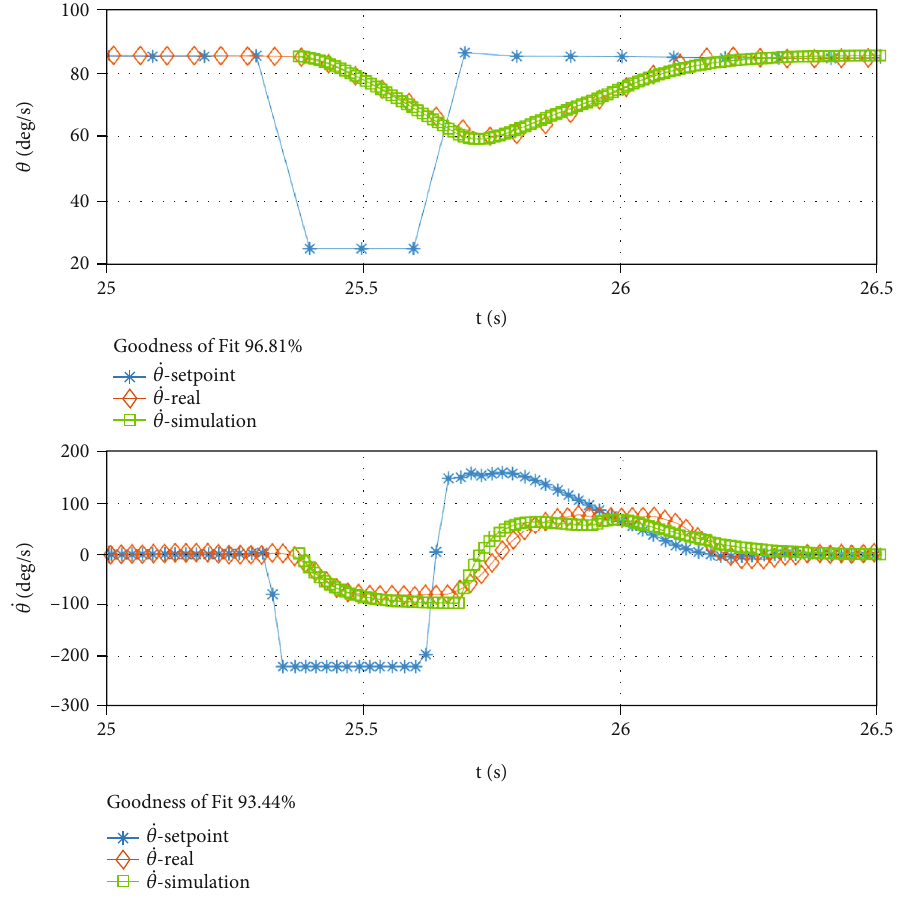
Figure 9: Pitch mode dynamic response comparison under a 0.3-s impulse